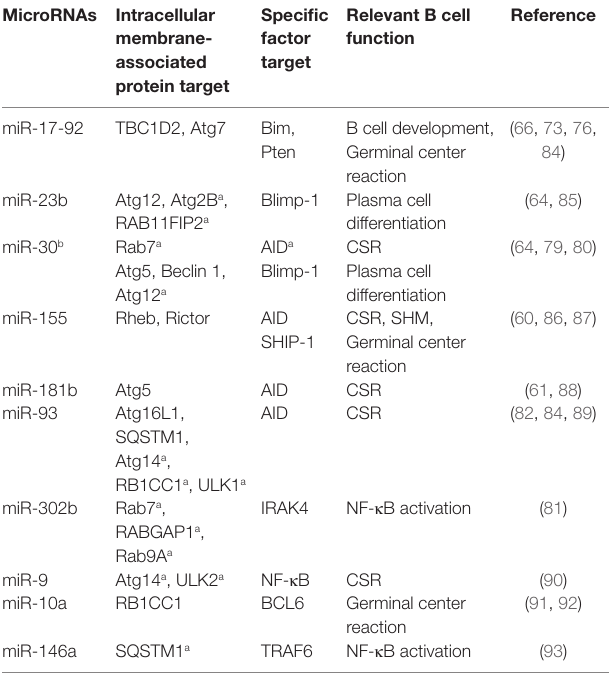
TABLe 1 | MicroRNAs target intracellular membrane-associated proteins and factors critical for B cell differentiation and functions. MicroRNAs intracellular